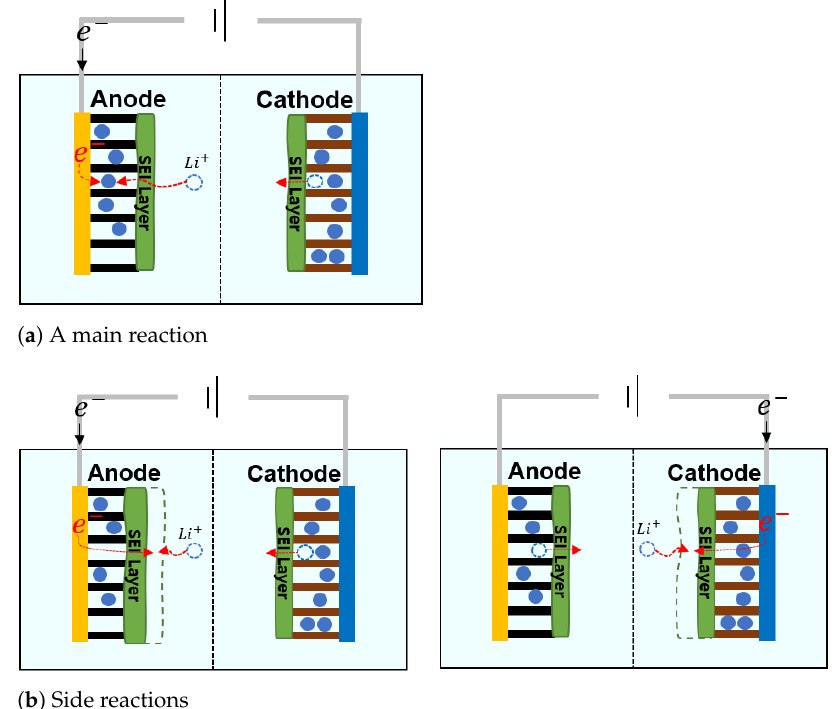
Figure 2. The difference with main reaction and side